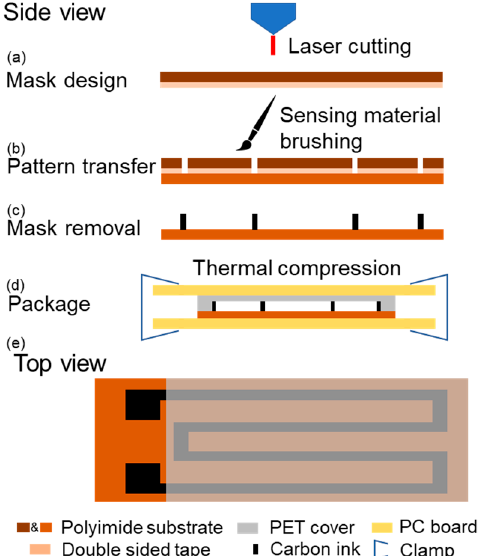
Figure 2. Brief illustration of the strain sensor fabrication steps using an optimized shadow mask and package approaches .